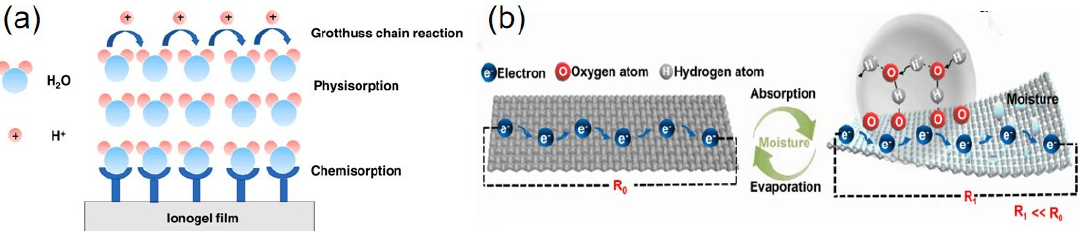
Figure 1. Example of the Grotthuss mechanism: ( a ) illustration of the humidity-sensing mechanism of the PIL (reproduced with permission from [32]); ( b ) principle of the OCF sensor (reproduced with permission from [33]).